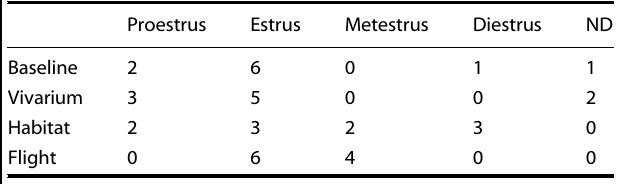
Fig. 1 Hematoxylin and eosin staining of vaginal walls used for estrous cycle staging. Vaginal wall estrous cycle staging was completed on all mice ( n = 40). Representative sections from two fl ight and two habitat control mice depict each stage of the estrous cycle a proestrus, b estrus, c metestrus, and d diestrus. *Marks the vaginal lumen. Images were taken at ×20 using bright fi eld microscopy; scale bar measures 100 μ m. Table 1. Number of mice at each stage of the estrous cycle ( n = 10/